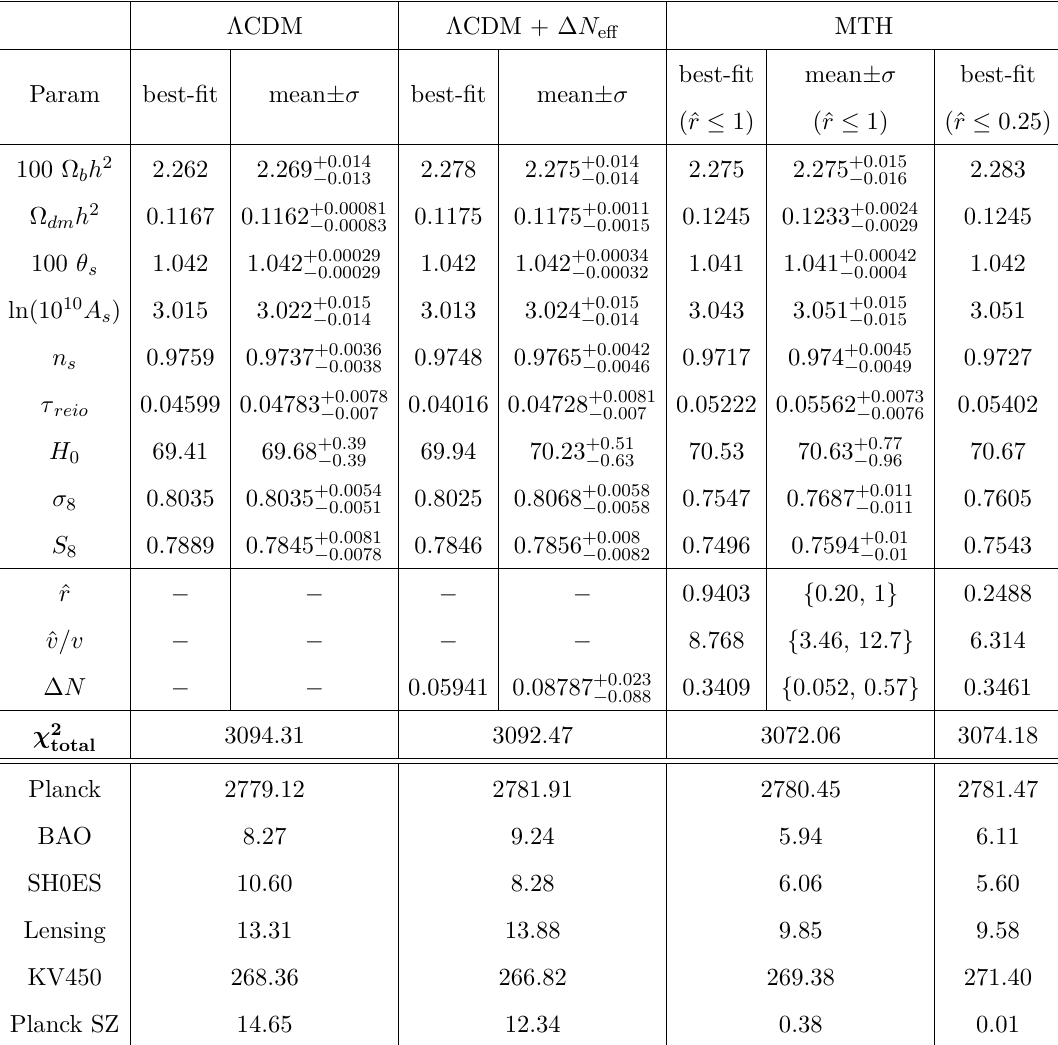
Table 2. The mean and best-fit values for the Λ CDM, Λ CDM + ∆ N eff and MTH models obtained using the Planck, BAO, SH0ES, KV450, and Planck SZ datasets. ∆ N corresponds to ∆ N Λ CDM + ∆ N model and ∆ ˆ N for the MTH model. For the MTH parameters, the range allowed eff at 95% C.L. is shown in brackets. In the lower part of the table, total χ 2 of the best-fit points of the three models, along with the breakdown of contributions from the different datasets, is shown. χ 2 for the Planck Lensing data is shown separately with the label “Lensing,” and is not included in the combined χ 2 for